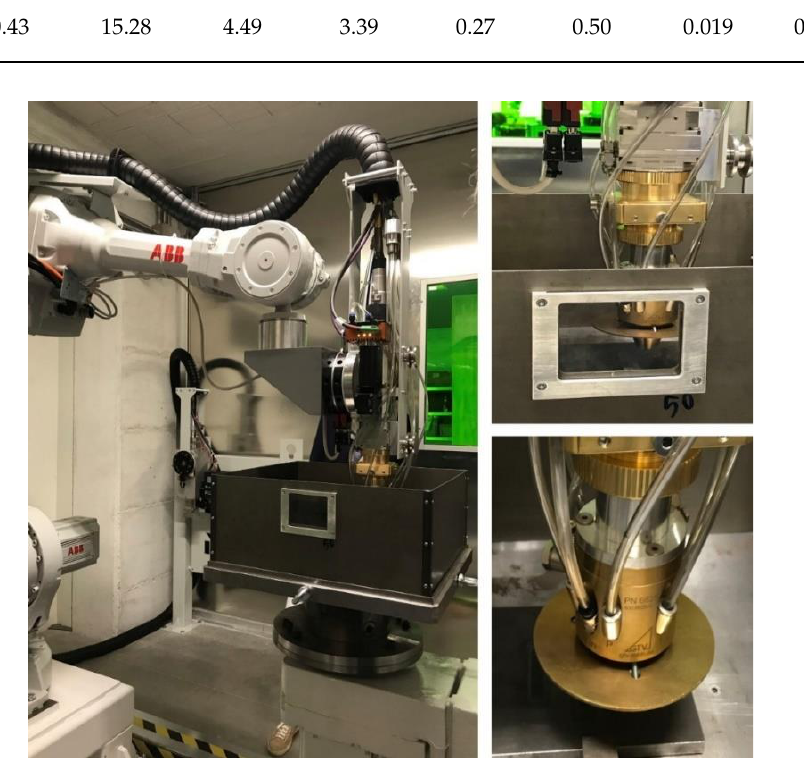
Table 1. Chemical composition [wt. %] of the 17-4 PH powder employed for the DED single-track depositions.